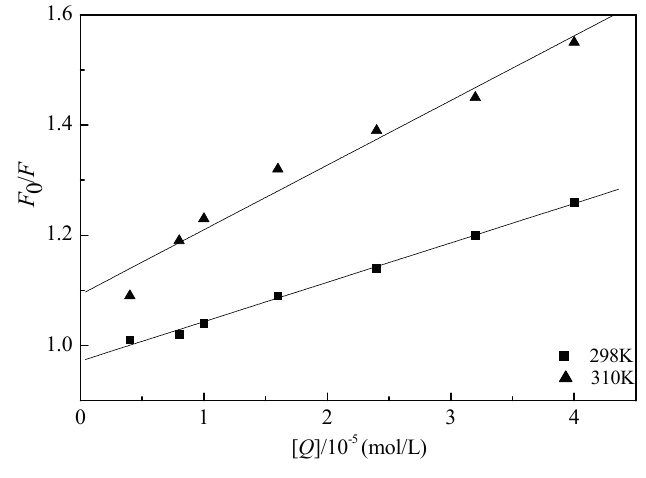
Figure 4. Stern-Volmer plot for the fluorescence quenching of LYS by GA (298 and 310